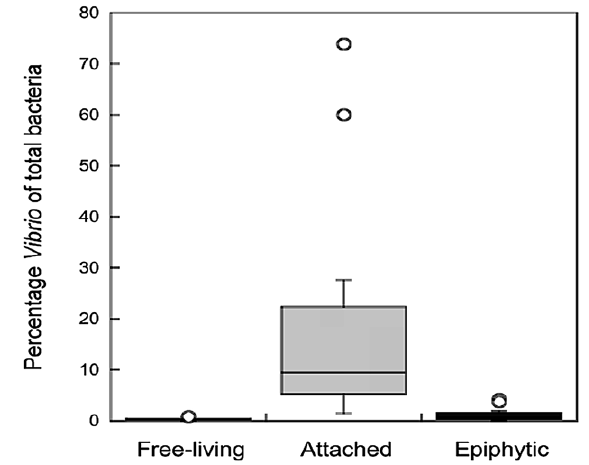
Fig. 6. – Concentration of planktonic free-living and attached Vi- brio , and percentage contribution of vibrios to the attached bacterial community.